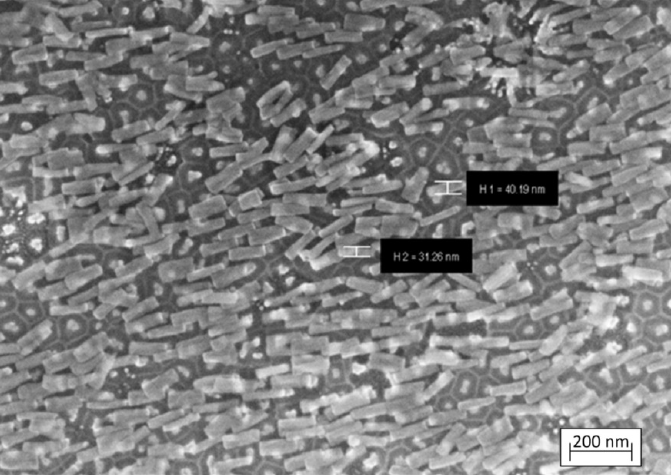
Figure 10. SEM image of the test sample with Ta 2 O 5 /Ni pillars after submersion in a diluted aqueous solution of phosphoric acid (sample 2, type I).